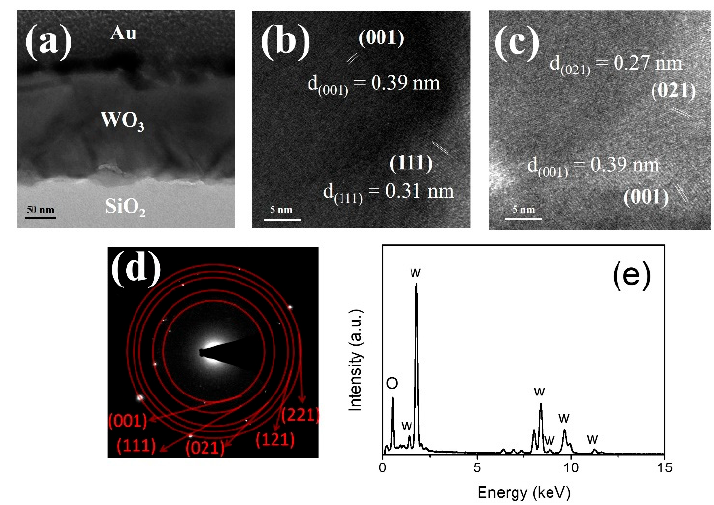
Figure 5. TEM analysis of the WO 3 film annealed at 600 °C: ( a ) low-magnification image, ( b , c ) HR images, ( d ) SAED pattern, ( e ) EDS spectra.